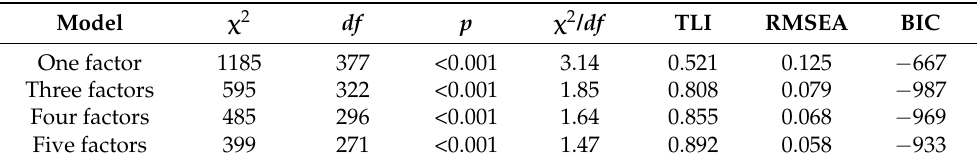
Table 2. Comparison between fit indices deriving from EFA of the models of the MSBS with one, three, four, and five factors.